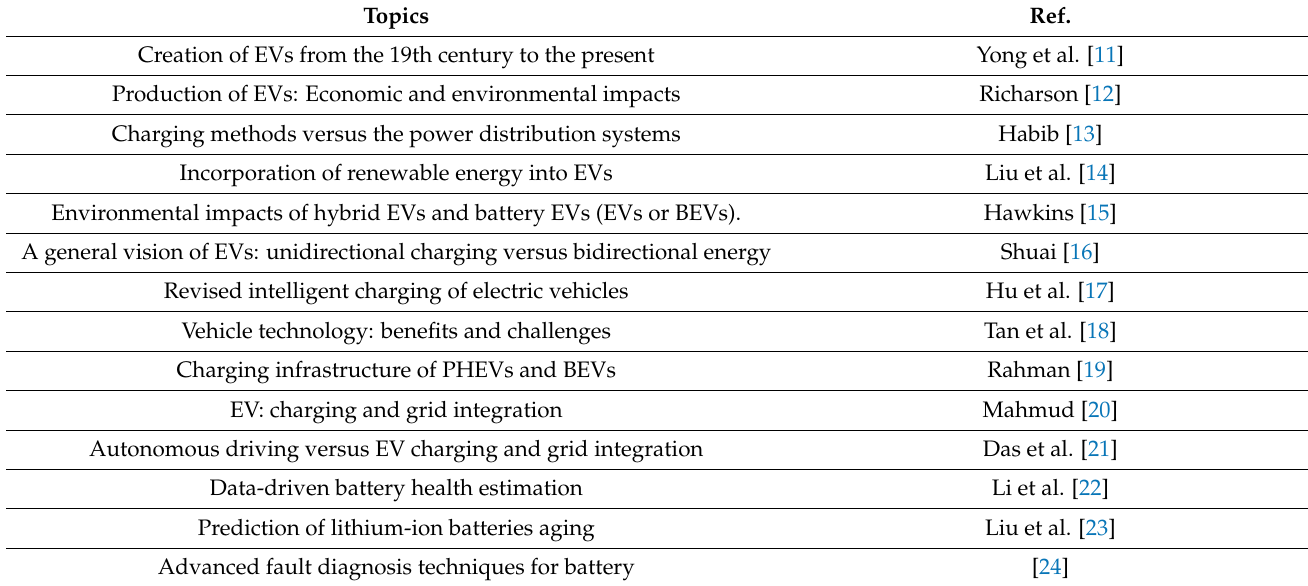
Table 2. Literature surveys on the production, performance, and other features of